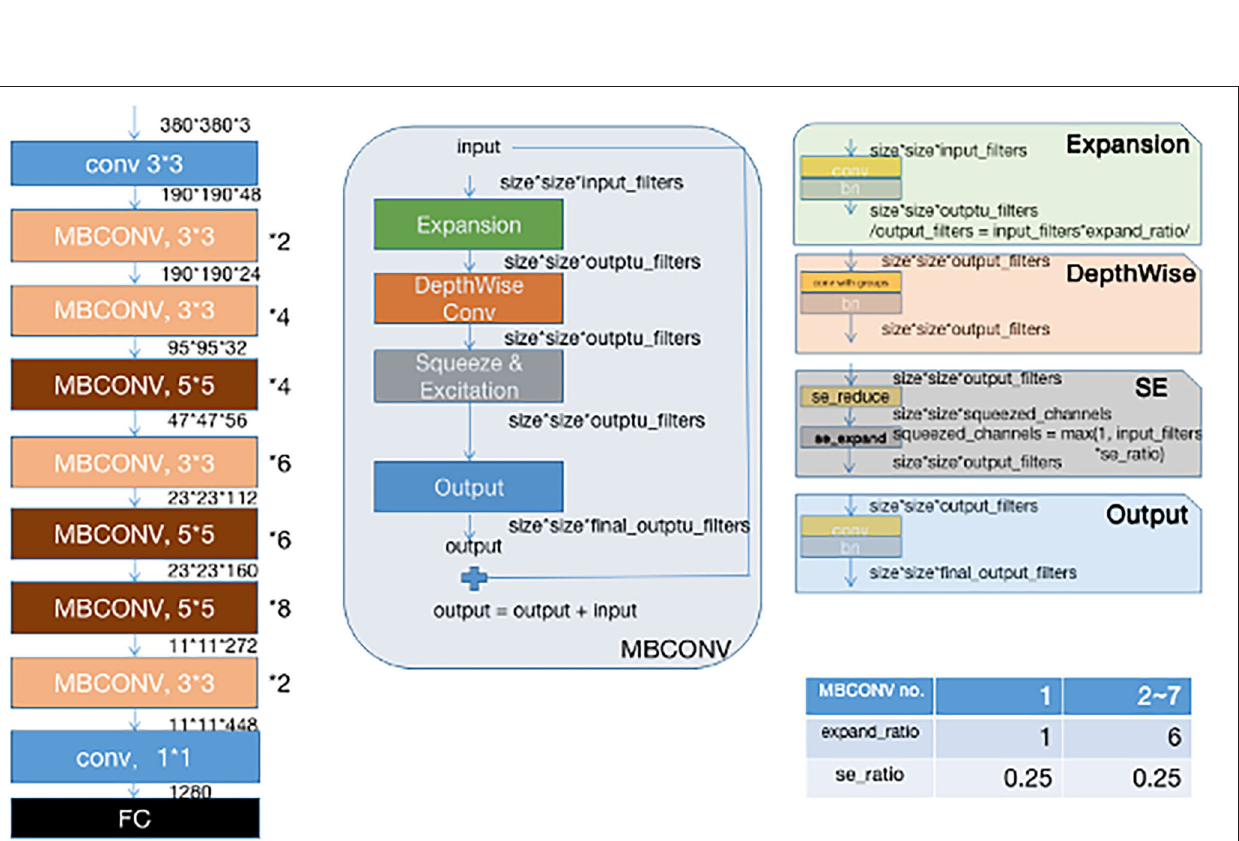
FIGURE 1 | Original efficientnet-b4